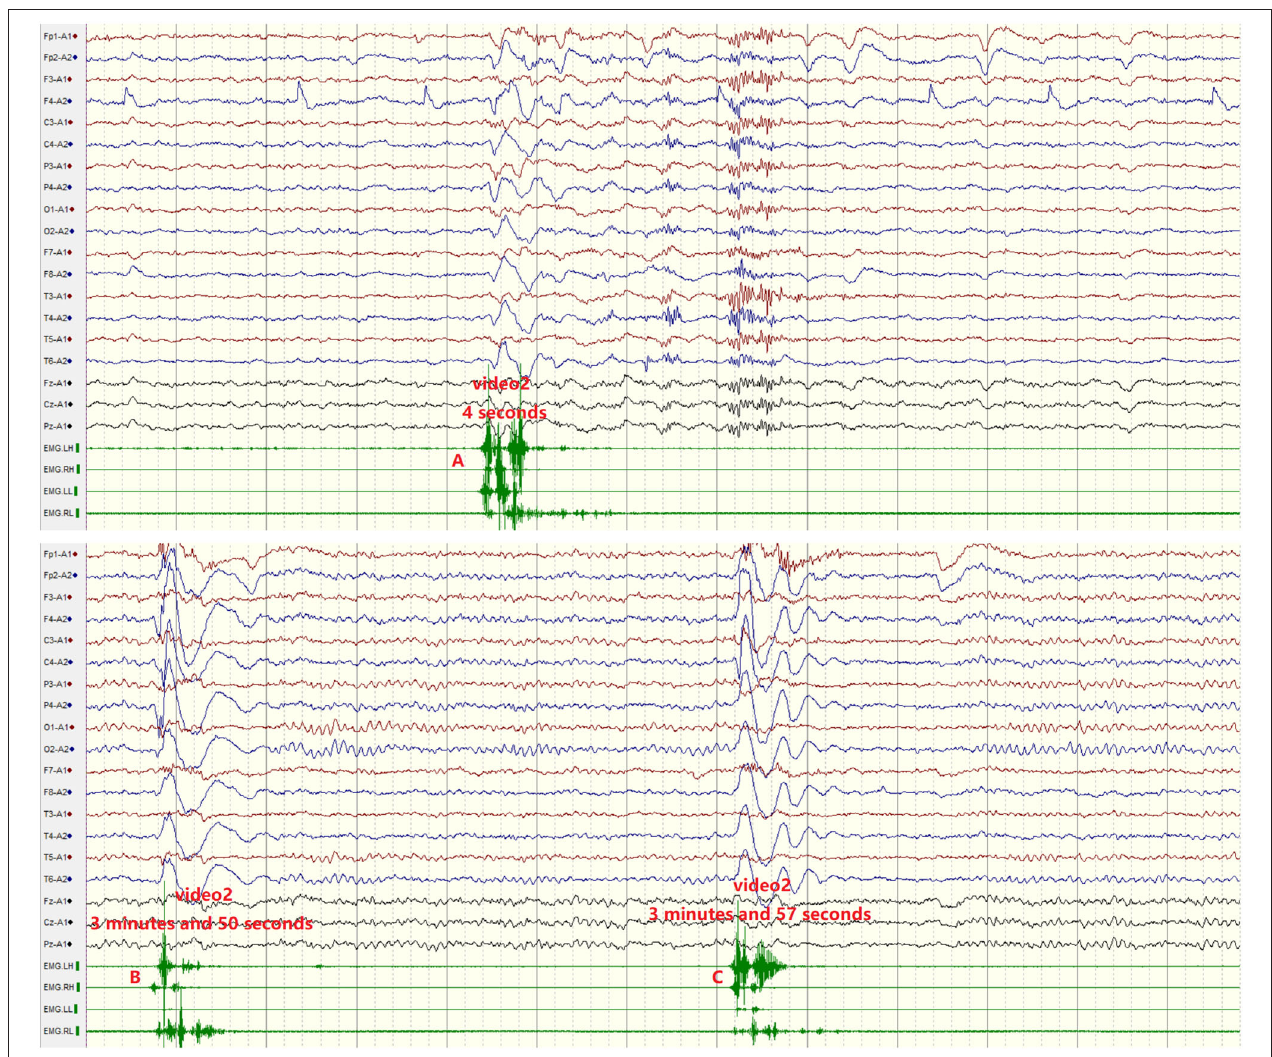
FIGURE 1 | Migrating myoclonus in patient 4. (A) According to myoelectric activity on electromyography (EMG), EMG showed myoelectric activities of the left limbs preceding the right limbs. Electrographical artifacts were observed, along with myoclonus. (B) Myoclonus spreads from the right upper limb to other limbs. (C) Myoclonus involved the bilateral upper limbs